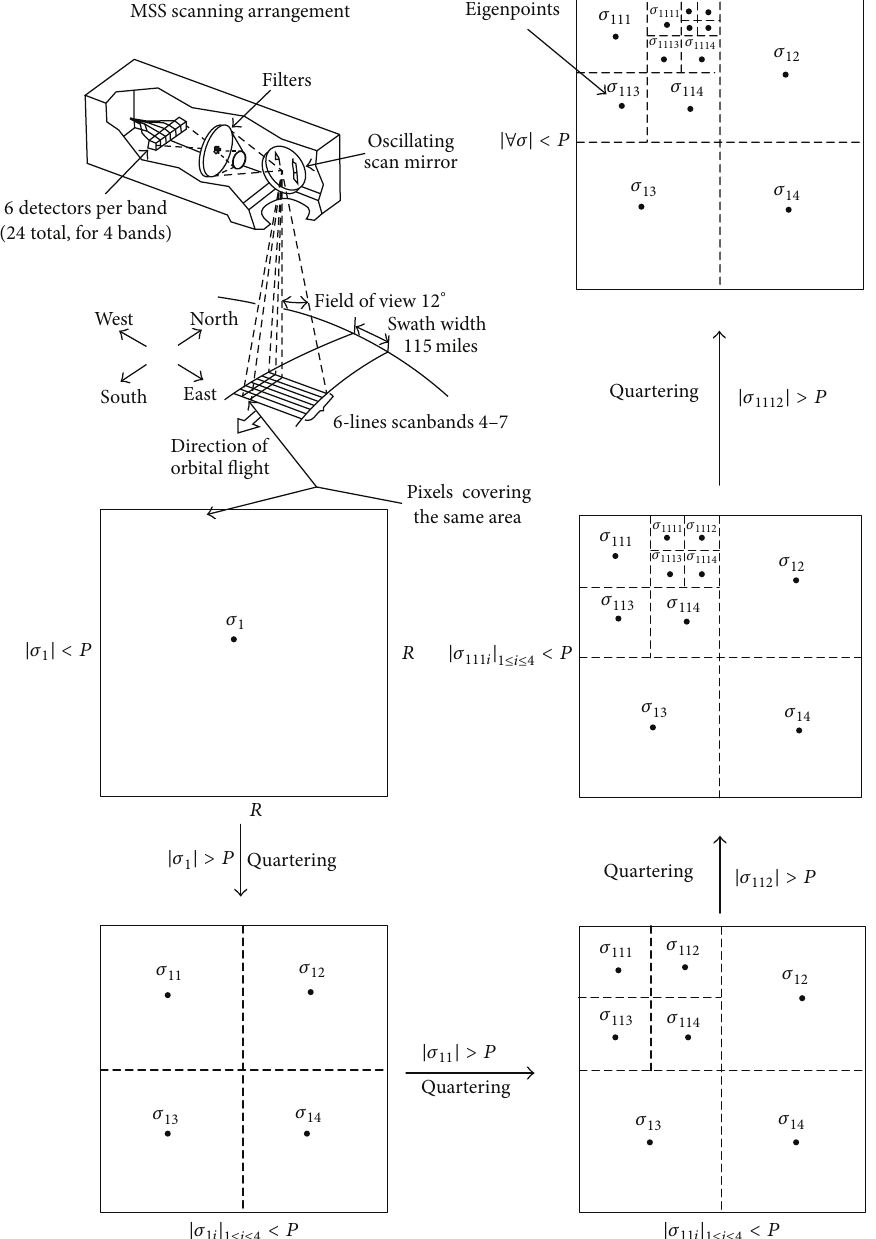
Figure 2: The four-level decomposition flowchart of the proposed method used to find